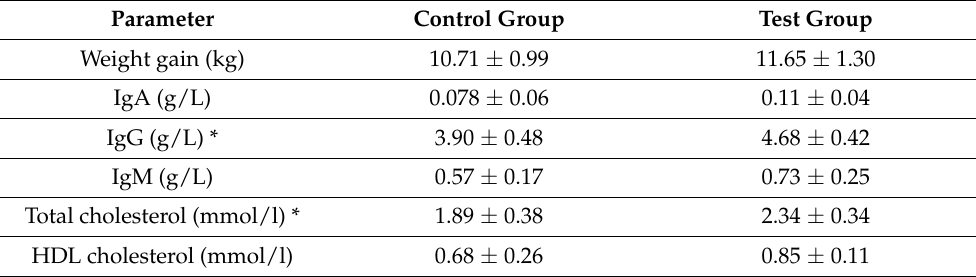
Table 1. Cholesterol, immunoglobulin and weight gain measurement comparisons between test and control groups at 28